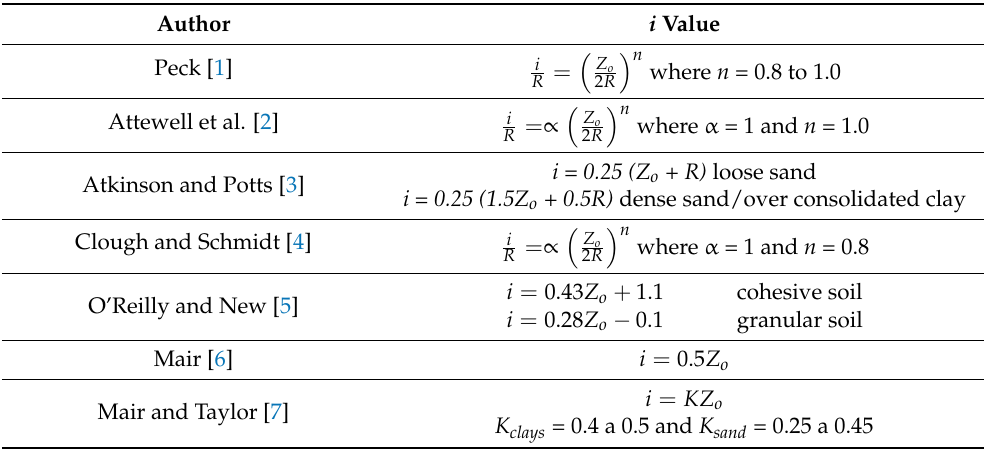
Table 1. Inflection dimension proposed by various researchers.